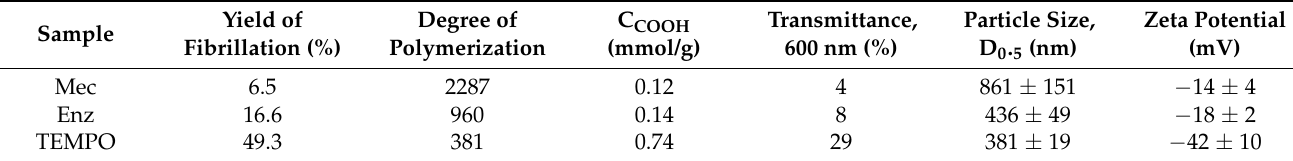
Table 1. Characterization data of the obtained CNF